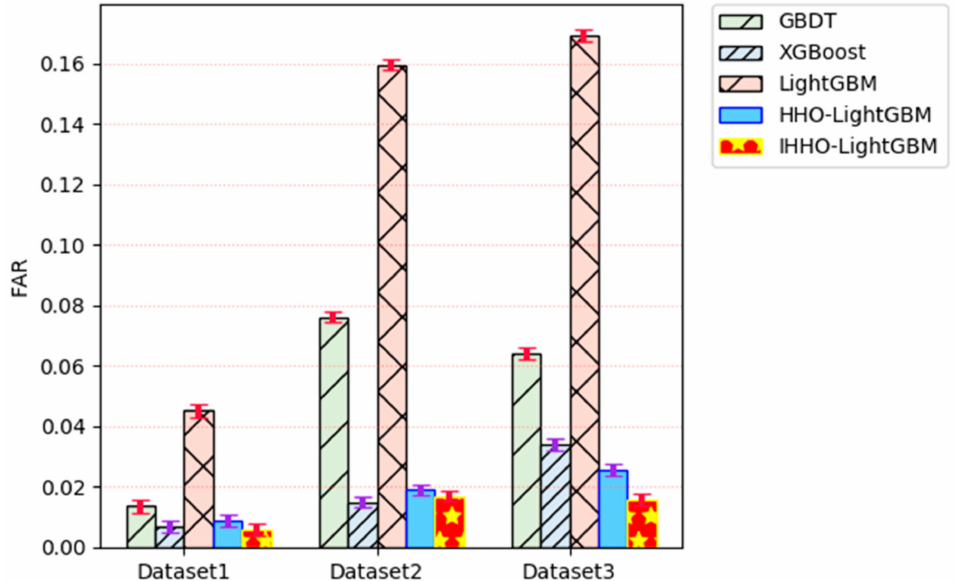
Figure 6. FAR of four algorithms for fault detection.